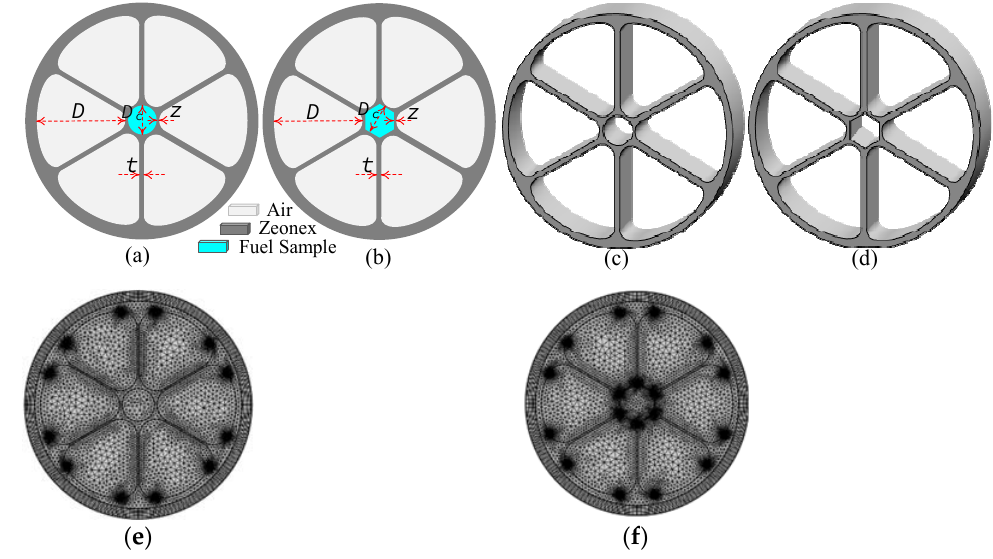
Figure 1. 2D view of ( a ) circular, and ( b ) hexagonal core configuration, and 3D view of ( c ) circular, and ( d ) hexagonal core configuration and meshing of ( e ) circular, and ( f ) hexagonal core configuration of the proposed grapefruit hollow-core PCF.